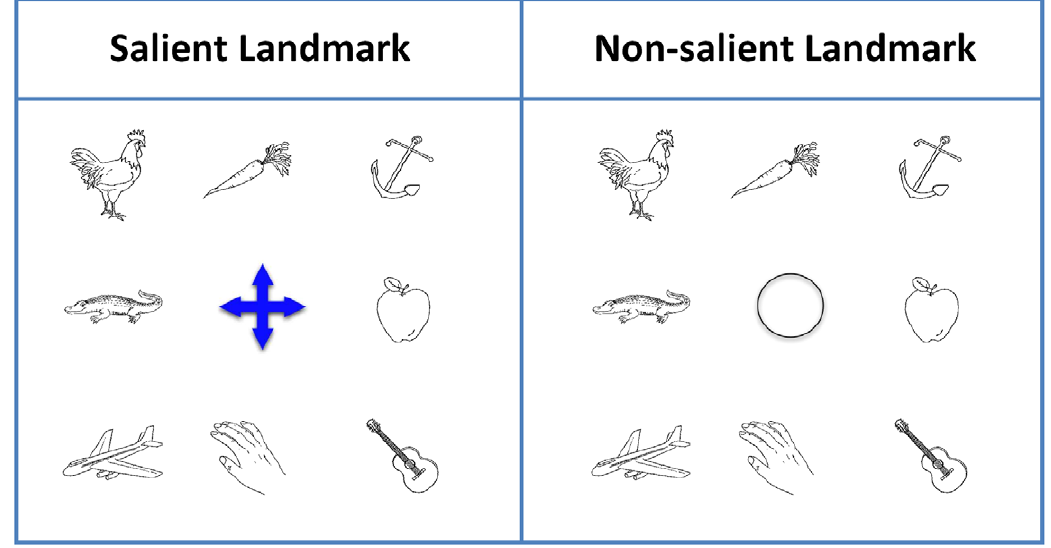
Figure 1. The object layout in Experiment 1. The cross in the middle of the object array in the salient condition was made perceptually distinctive with blue coloring while all other objects were in black-and-white.